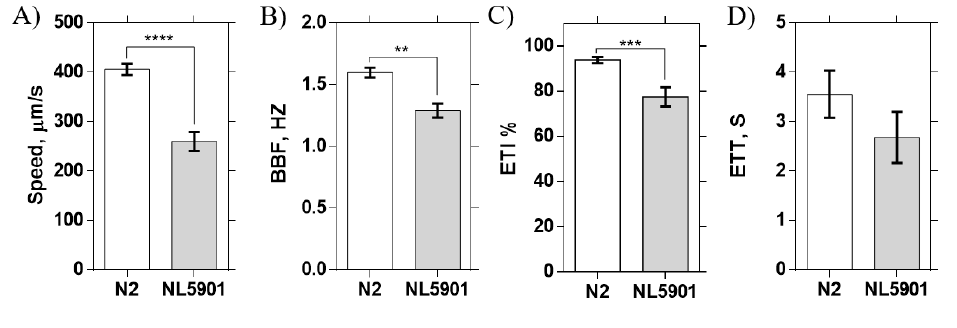
Figure 4. Application of the microfluidic device to mutant screening using NL5901 strain expressing α -syn (N = 19/21 responders) at EF = 3.7V/cm. ( A ) Worm speed, ( B ) body bend frequency (BBF), ( C ) electrotaxis time index (ETI) of responder worms, and ( D ) electrotaxis turning time (ETT). Error bars are SEM; *: p < 0.05; **: p < 0.01; ***: p < 0.001; ****: p <